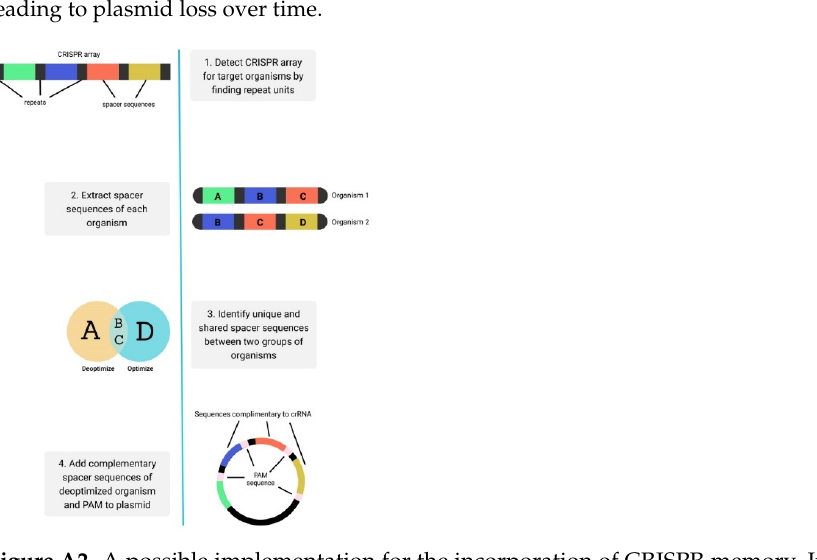
Figure A2. A possible implementation for the incorporation of CRISPR memory. Insertion of sub- sequences that are unique to the memory system of unwanted hosts in order to promote selective cleavage and digestion of the plasmid only in unwanted hosts.